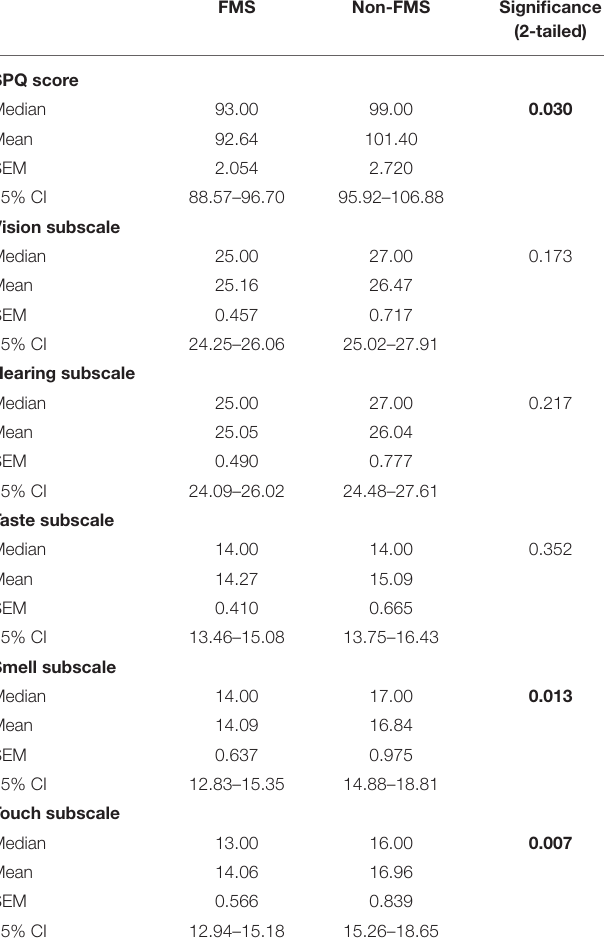
TABLE 2 | Comparison of hypersensitivity between FMS and non-FMS chronic TABLE 1 | Comparison of overall sensory sensitivity between FMS and non-FMS pain groups. chronic pain groups. FMS Non-FMS Significance FMS Non-FMS Significance (2-tailed)